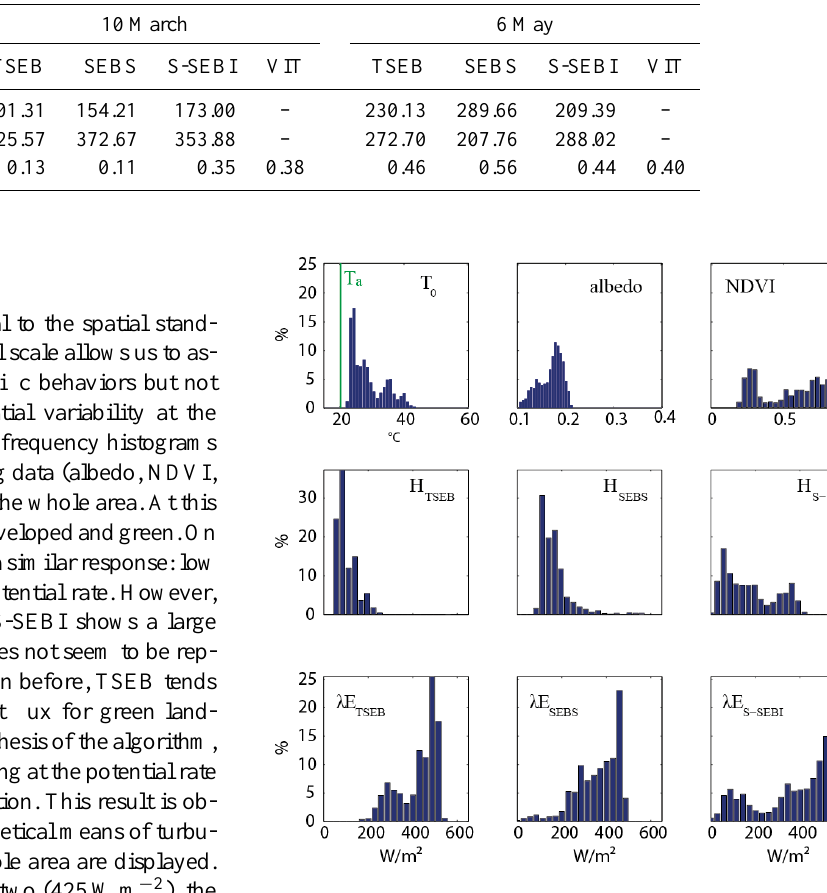
Fig. 11. Frequency histograms of simulated turbulent-calculated fluxes and remote sensing parameters on 10 March. On the T 0 his- togram, the value of air temperature T a is indicated as a green